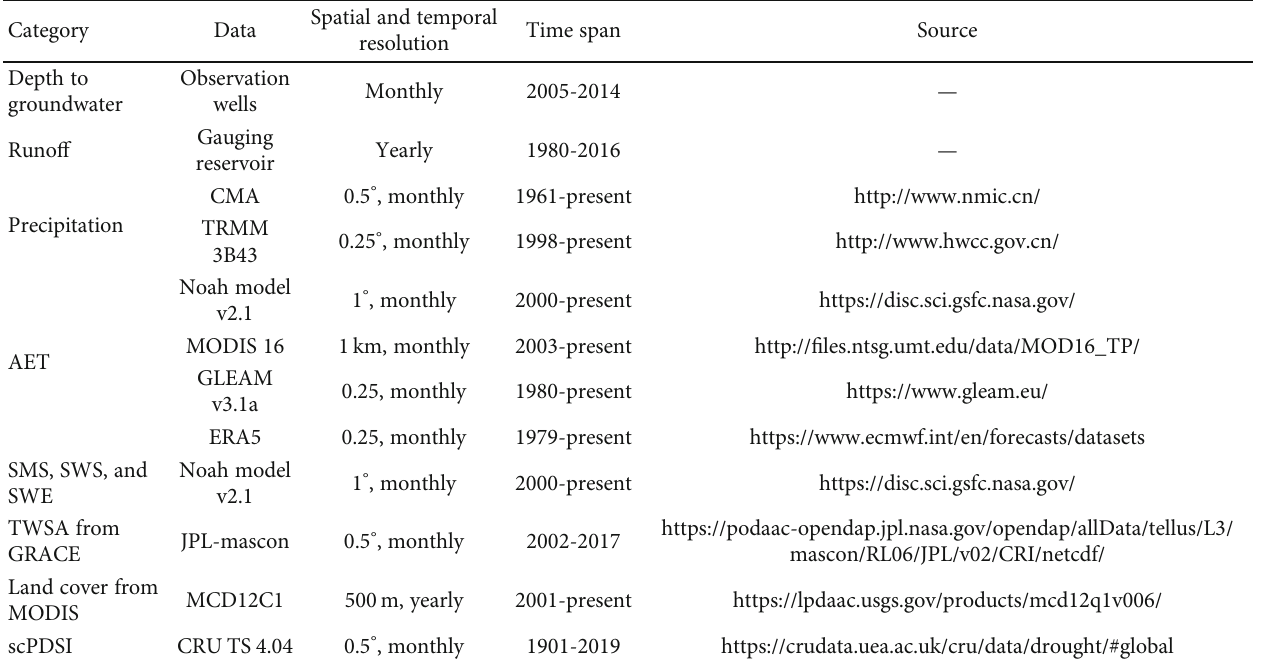
Table 1: List of data sources used in this